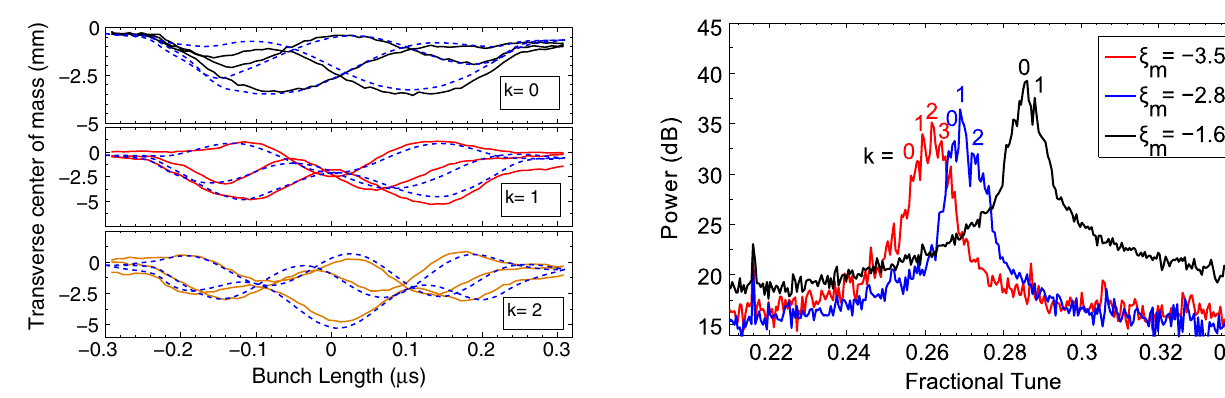
FIG. 23. Relative signal amplitudes of various head-tail modes are plotted with respect to the measured chromaticity. The centroid of the spectrum moves toward higher order modes with increase in chromaticity.